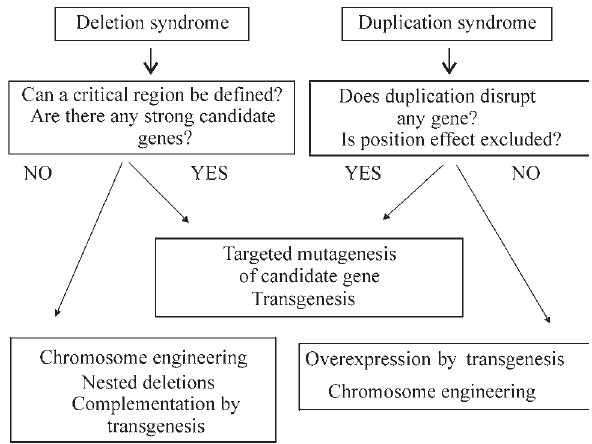
Figure 4 - Schematic representation of the most probable pathways lead- ing to the production of a mouse model for a specific genomic